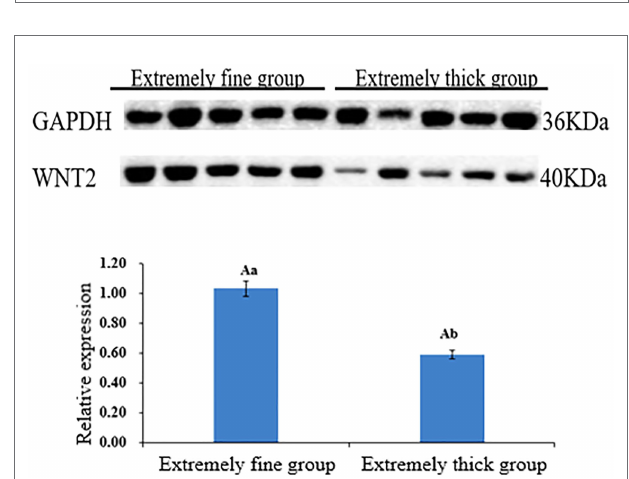
FIGURE 8 | Expression of WNT2 gene in different tissues at 135 d of embryonic stage. Different lowercase letters indicate significant difference ( p < 0.05), and different uppercase letters indicate extremely significant difference ( p < 0.01), the same letter expressed surprise was not significant ( p >